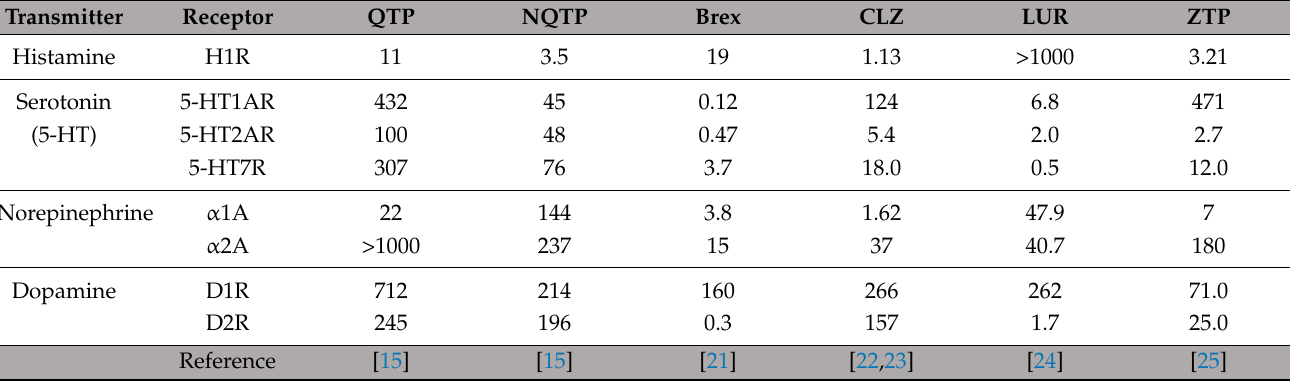
Table 1. Receptor binding profiles of quetiapine and other mood stabilizing atypical